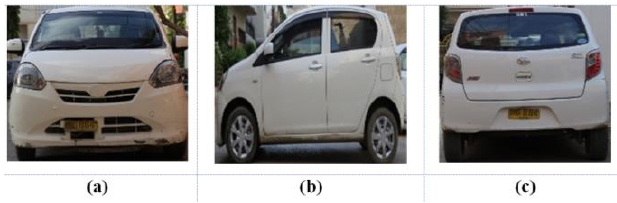
Fig. 4. Photographic technique for Daihatsu Mira X (a) Front view (b) Side view (c) Back